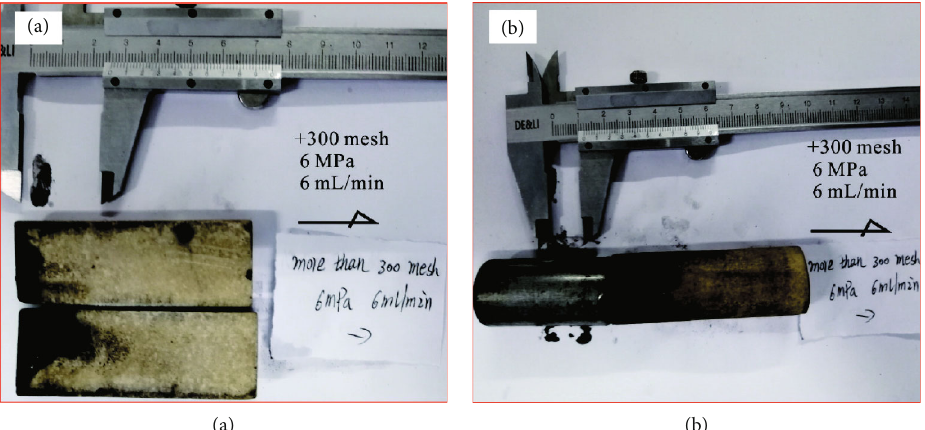
Figure 10: The characteristic of coal fi nes intrusion at 300+ mesh, 6mL/min, and 6MPa. (a) The characteristic of coal fi nes intrusion. (b) The characteristic of coal fi nes